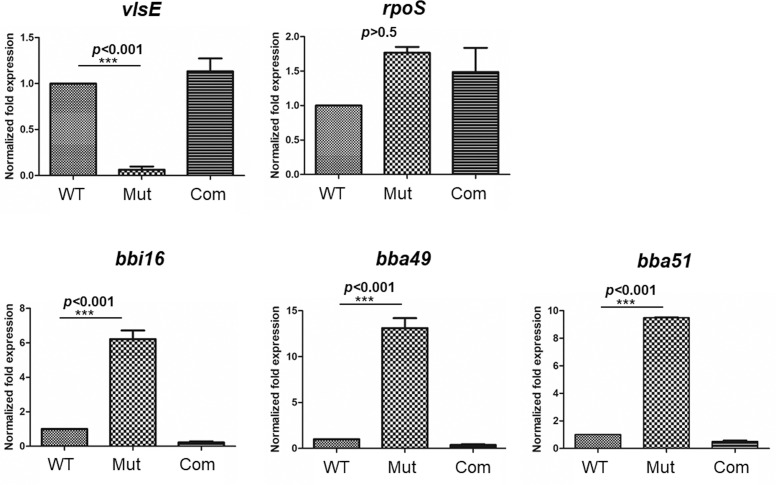
qRT-PCR verification of positively or negatively regulated genes by YebC identified by RNA-seq.Wild-type B. burgdorferi strain 5A4NP1 (WT), the yebC mutant (Mut) and the complemented strain (Com) were cultured in BSK-II medium at pH 7.5 and harvested at the mid-log phase. RNAs were extracted and subjected to qRT-PCR analyses for expression of vlsE, rpoS, bbi16, bba49, bba51. The expression levels for each gene in wild-type strain are set as 1.0. The bars represent the mean values of three independent experiments, and the error bars represent the standard deviation. ***, p < 0.001 using one-way Anova.